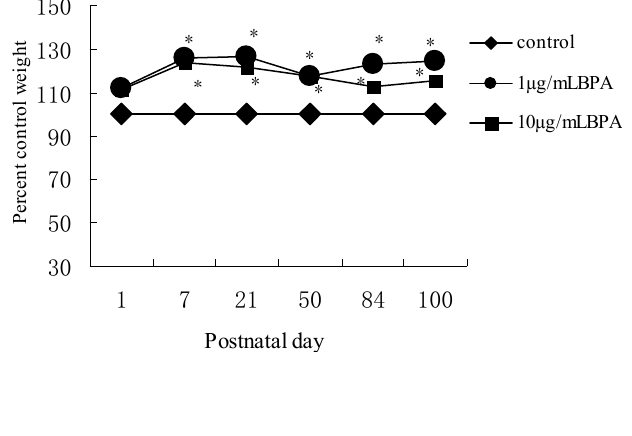
Figure 1. Effect of perinatal exposure BPA on body weight from postnatal day 1 (PND1) to PND100 in male offspring. Pregnant rats ( n = 7/group) were exposed to vehicle or BPA in water at levels of 1 or 10 µg/mL from gestation day 6 through the end of lactation. Values represent the mean ± SE ( n = 7, one from each group). * p < 0.05 compared with